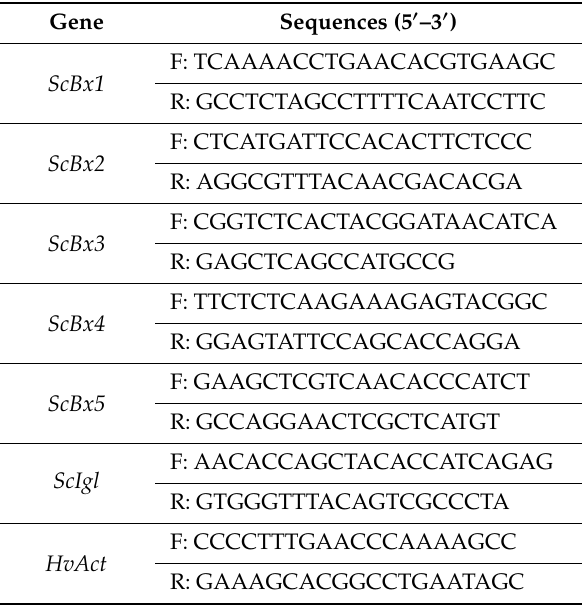
Table 1. Primers used in quantitative real-time PCR